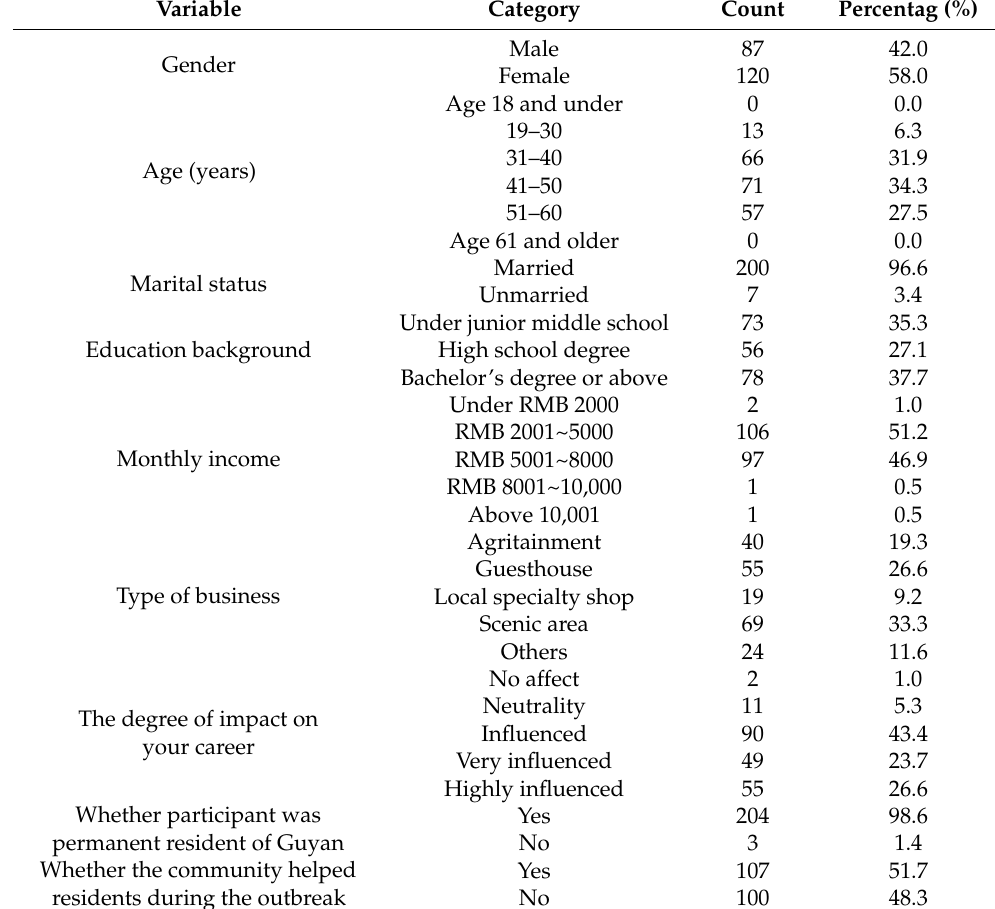
Table 1. Demographic information for